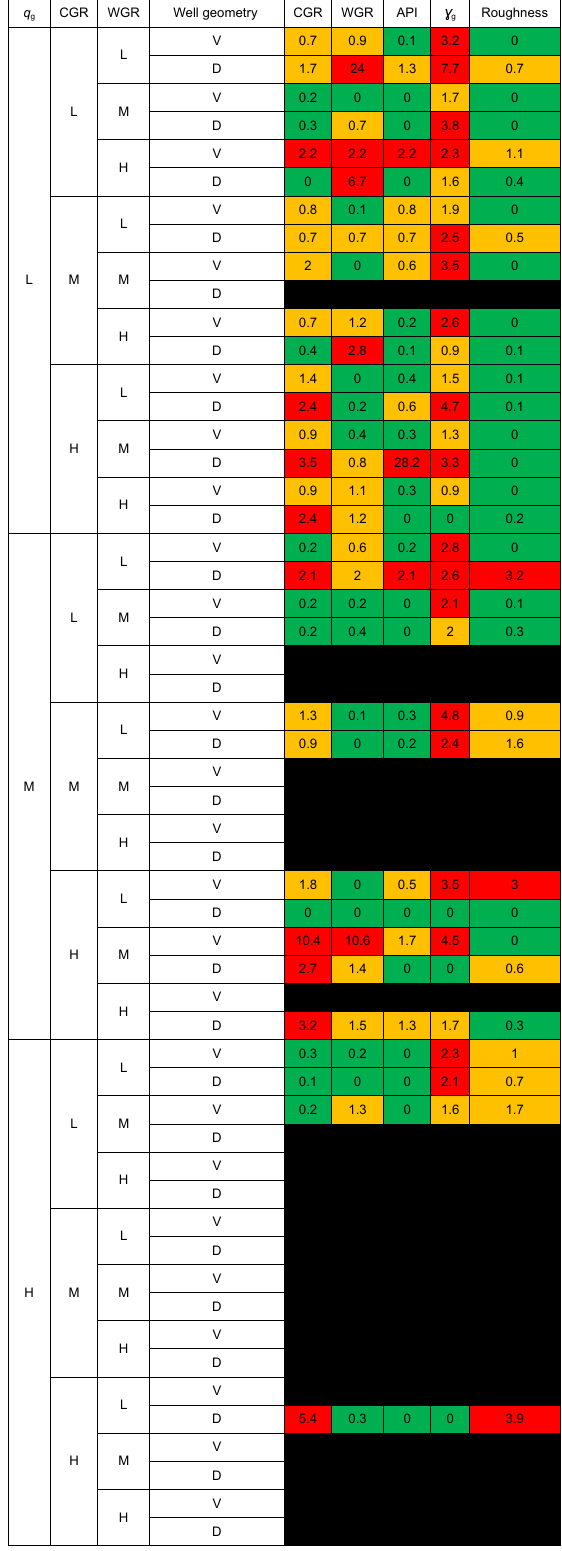
Table 7 Effect of changing input parameters on the